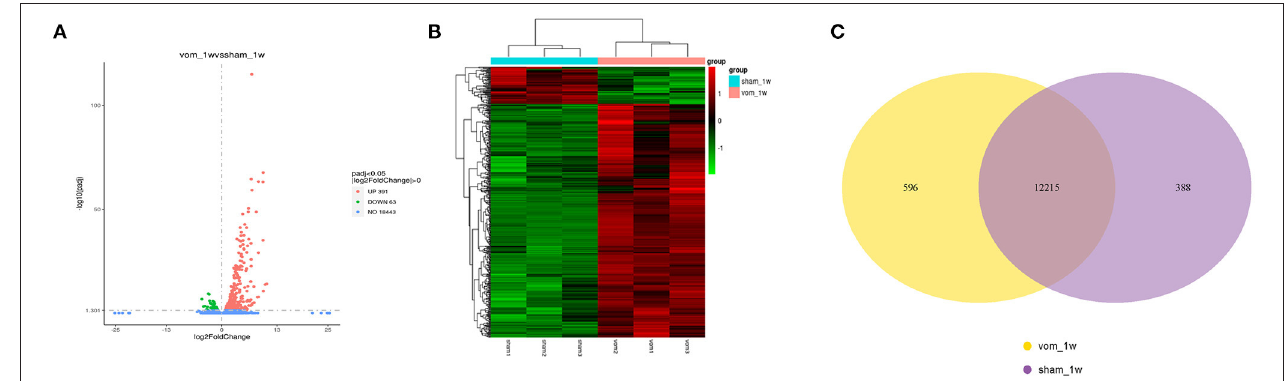
FIGURE 3 | The transcriptome of the neonatal RV is altered by VO. (A) Volcano map of the differentially expressed genes between the vom and sham groups. There were 391 upregulated and 63 downregulated genes in the vom group. (B) Cluster analysis of the differentially expressed genes between the vom and sham groups. The clusters of genes in each group were quite different from each other but were similar within the same group. (C) Venn diagram of the differentially expressed genes between the vom and sham groups. These two groups shared 12,215 commonly expressed genes; there were 596 genes expressed only in the vom group and 388 genes expressed only in the sham